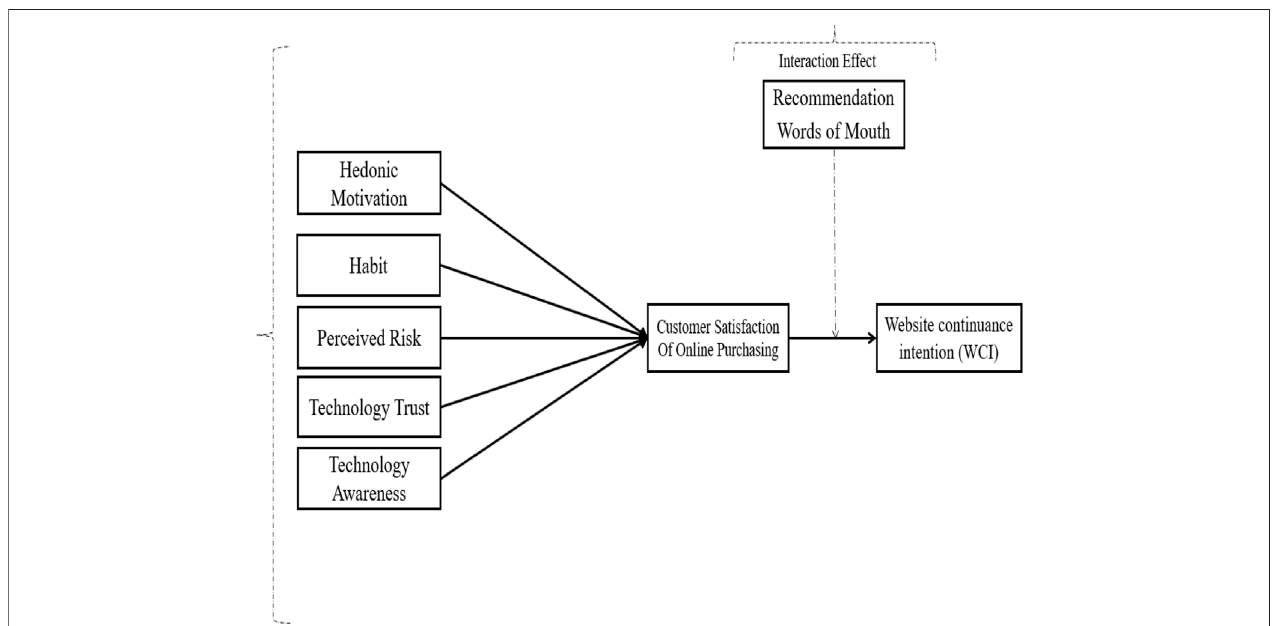
FIGURE 1 | Research